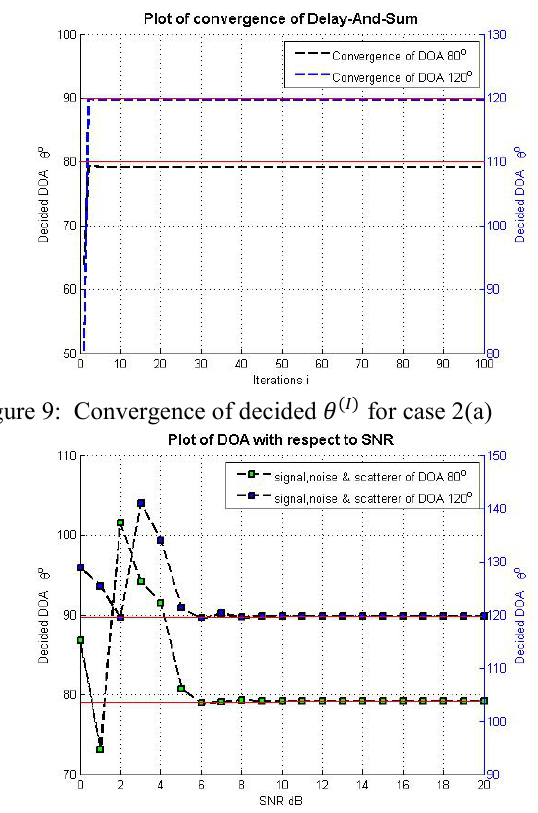
Figure 10: Plot of DOA with respect to SNR for case 2(a) 3.3. Case 2(b): Single Scatterer, Two Waves